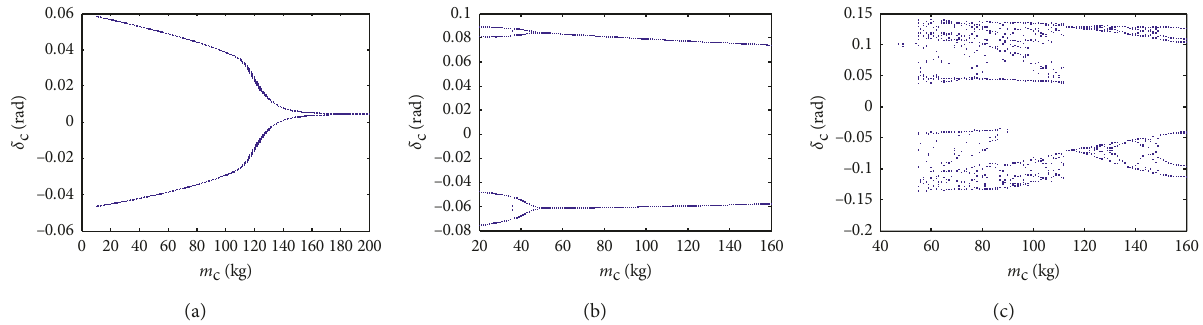
Figure 10: Effects of m c on the compliance steering angle δ c : (a) c (cid:30) 0.15, (b) c (cid:30) 0.2, and (c) c (cid:30)